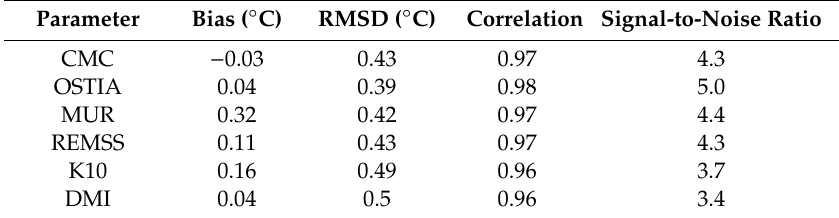
Table 1. Bias, RMSD, correlation, and signal-to-noise ratio for MUR, OSTIA, and CMC, with respect to the Saildrone-derived SST. REMSS, K10, and DMI products have been added for comparison.